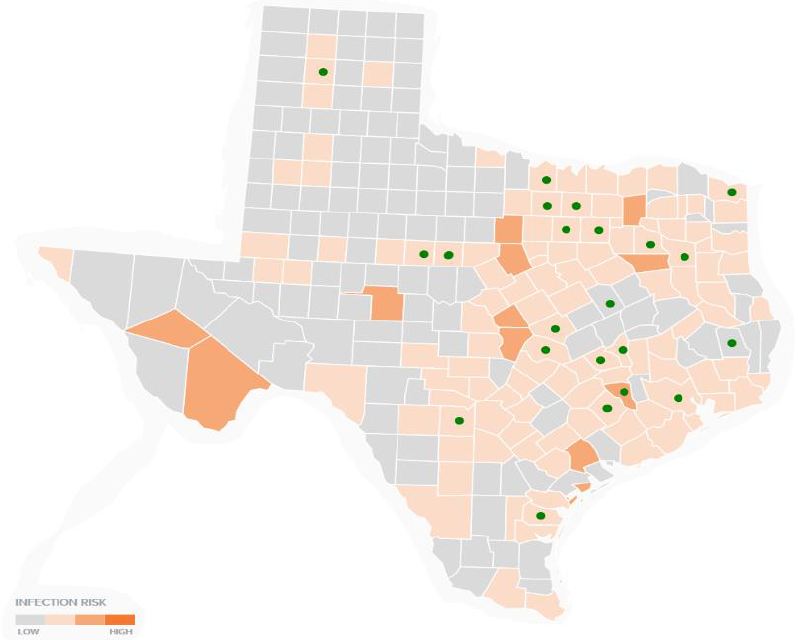
Figure 6. 2018 canine Lyme disease and TTS tick bite encounters. Data Source: Companion Animal Parasite Council, Ehrlichiosis Canine Report, 2018; Raw data source, IDEXX Laboratories and Antech Diagnostics.